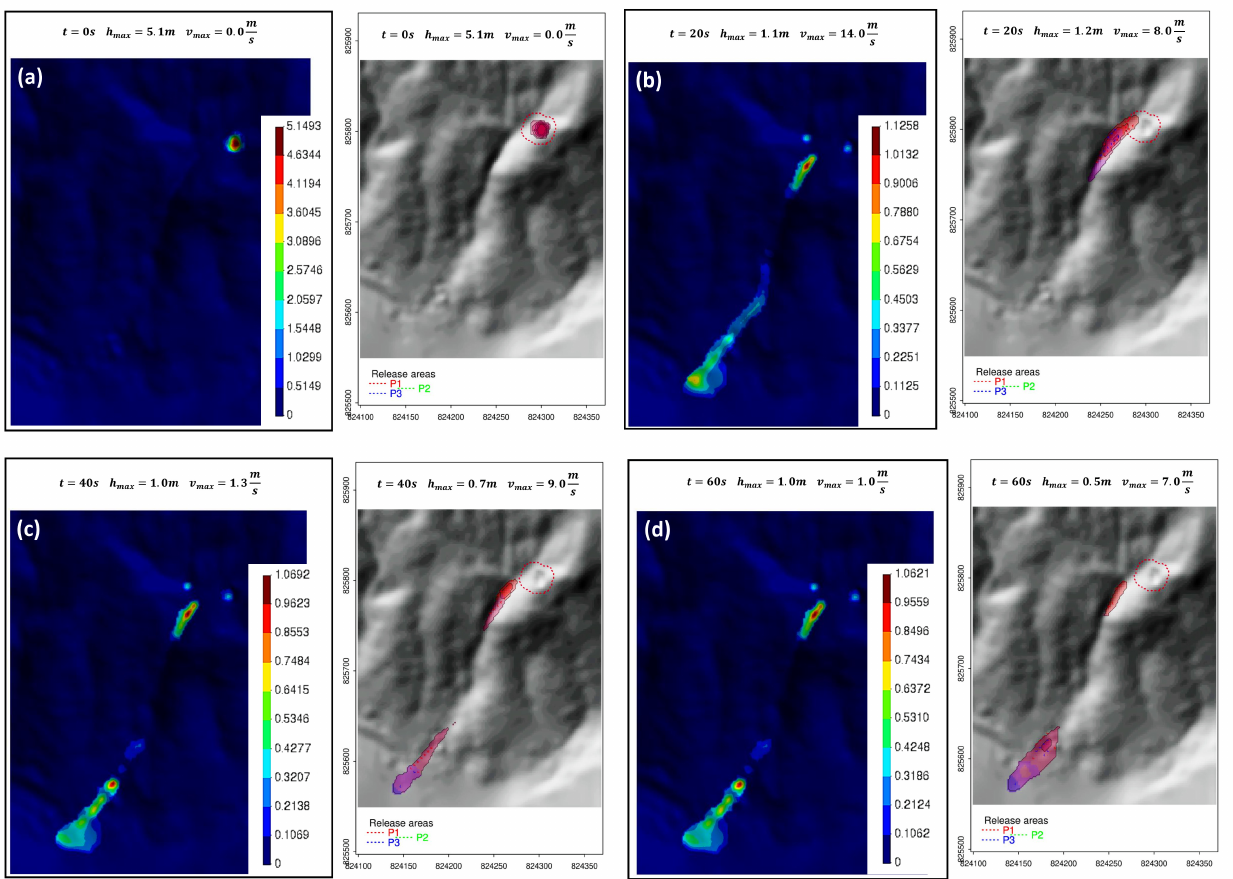
Figure 8. A comparison between two sets of code. The results on the left side were obtained with GeoFlow-SPH, and those on the right side with r.avaflow. They show the flow propagation path, with the numerical results of flow-depth and maximum velocity at different times: ( a ) 0 s, ( b ) 20 s, ( c ) 40 s, and ( d ) 60